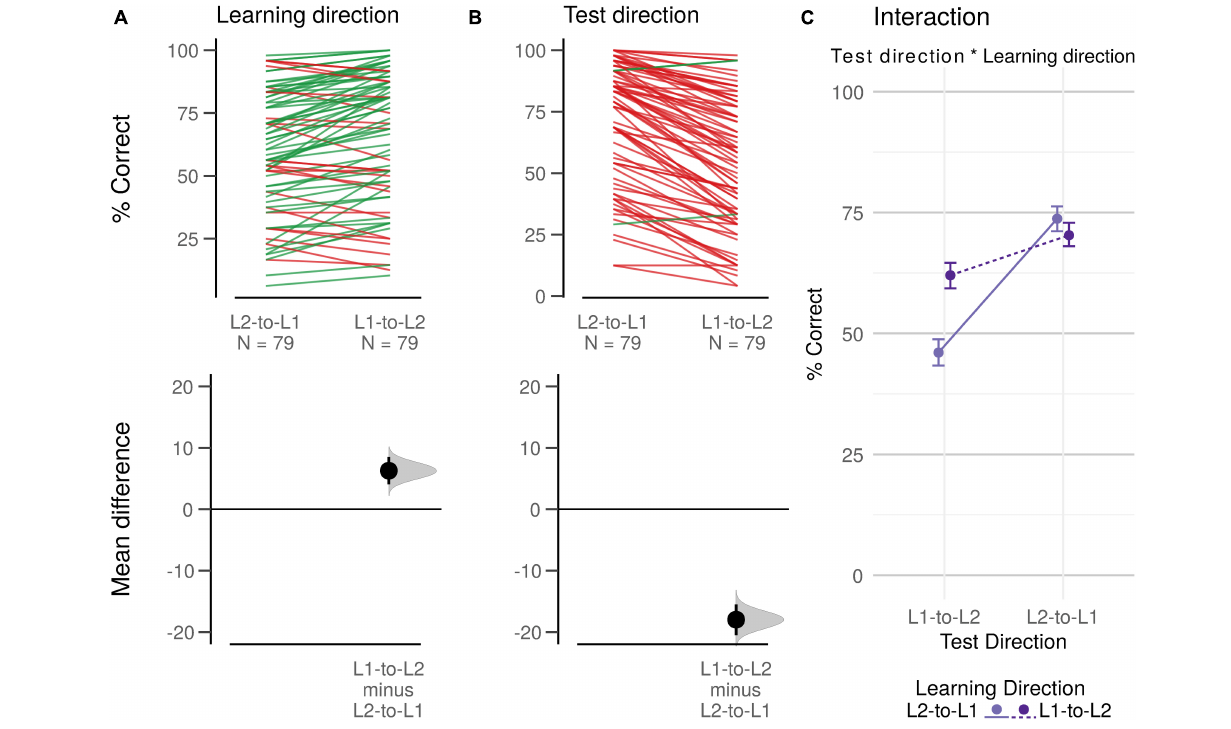
FIGURE 5 | Estimation plots and interaction plot for learning and testing direction. Estimation plots for learning direction (A) and testing direction (B) . Upper row shows paired individual participant data in slopegraphs. Lower row shows paired mean differences as a bootstrap sampling distribution, with the dot indicating the mean difference and the ends of the error bars indicating the 95% confidence interval. (C) Interaction plot. Values are offset horizontally to avoid over-plotting of error bars. Error bars indicate bootstrapped 95% confidence